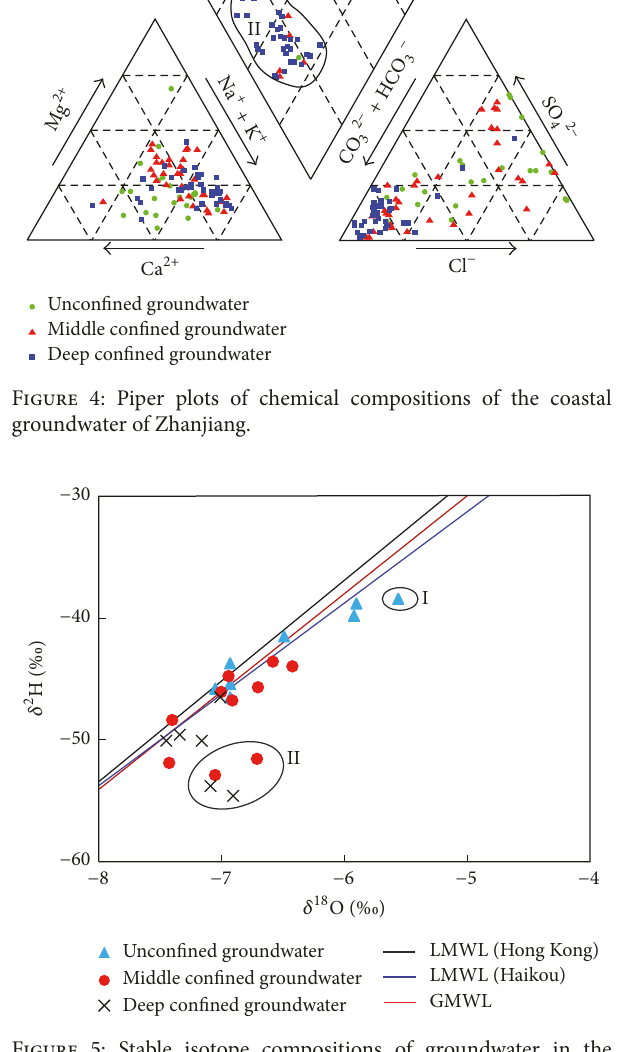
analysis results of 𝛿 18 O and 𝛿 2 H are shown in Table 2 and Figure 5. According to the monthly rainwater data obtained from the GNIP (Global Network of Isotopes in Precipitation) of the IAEA (International Atomic Energy Agency), the local meteoric water lines (LMWLs) of Hong Kong and Haikou weather stations were calculated as 𝛿 2 H = 8.28𝛿 18 O + 12.78 and 𝛿 2 H = 7.50𝛿 18 O + 6.18 , respectively. Then, these two LMWLs were used as the LMWL of Zhanjiang. As shown in Figure 5 and Table 2, the isotopic compositions of 𝛿 2 H